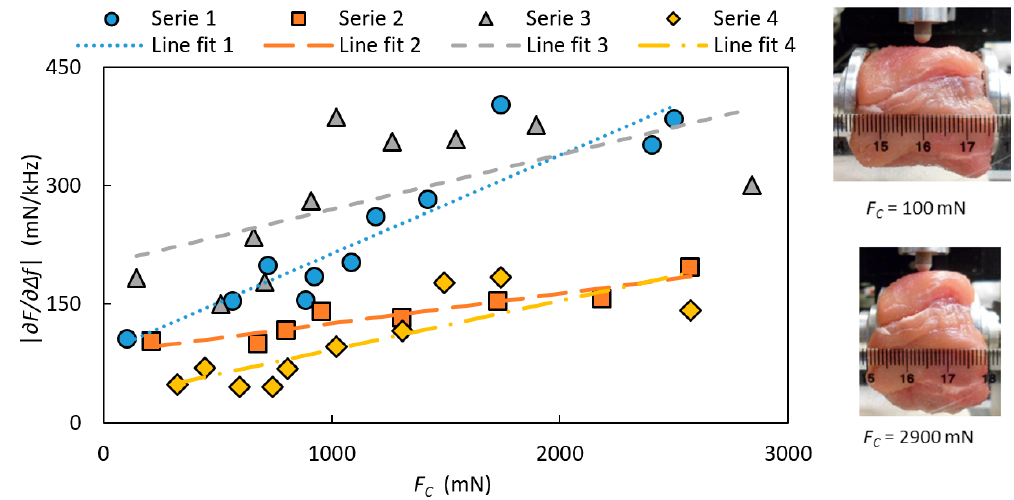
Figure 8. The stiffness parameter | ∂ F / ∂ ∆ f | for four separate measurement series as a function of the clamping force, F C measured on tissue from a porcine muscle with the indentation depth I = 0.6 mm and at the angle of sensor movement α sm = 0 ◦ . To the right, two pictures are illustrating the visible effect of F C on the tissue.